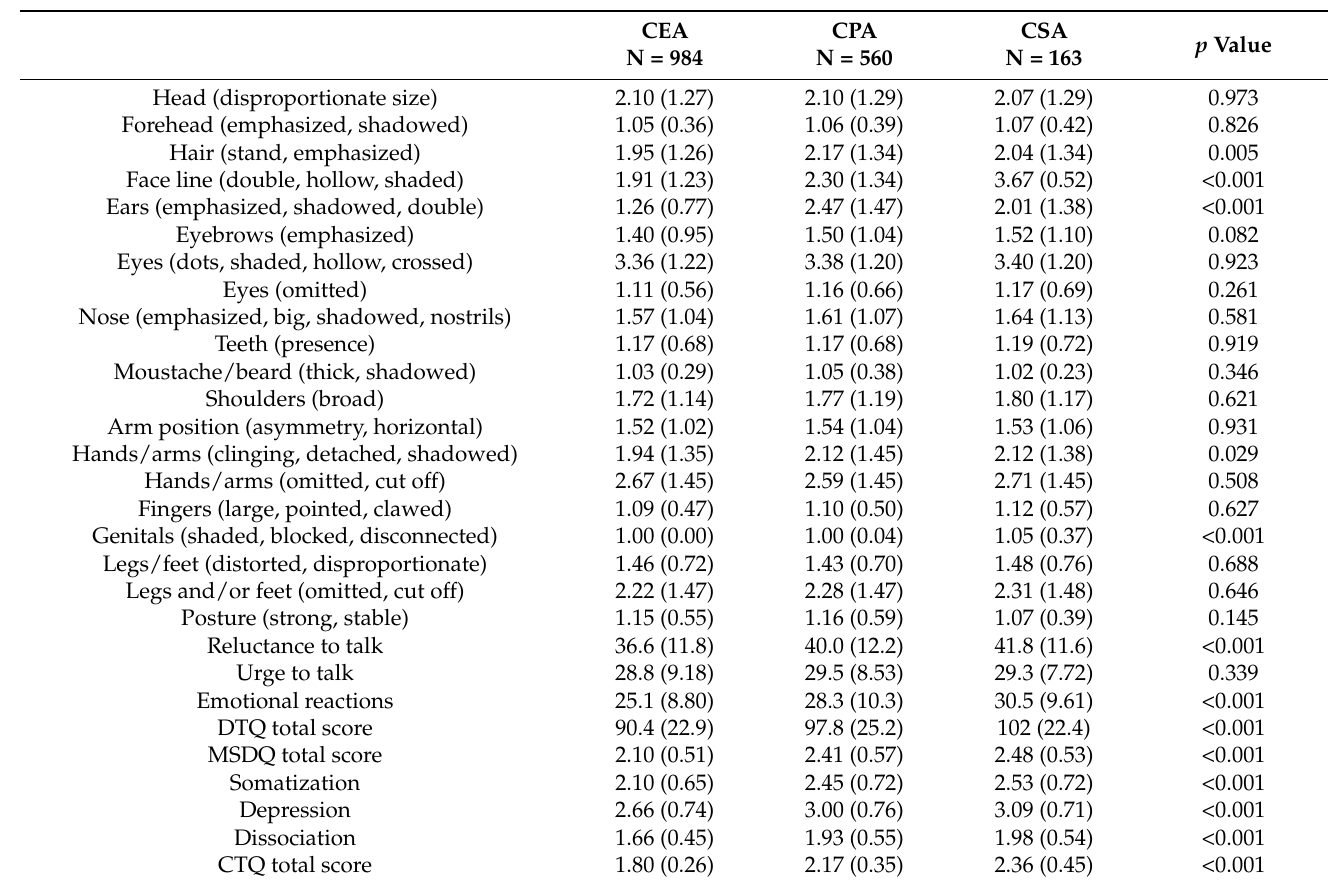
Table 1. Characterizing Drawing Indicators and Demographical Differences Across